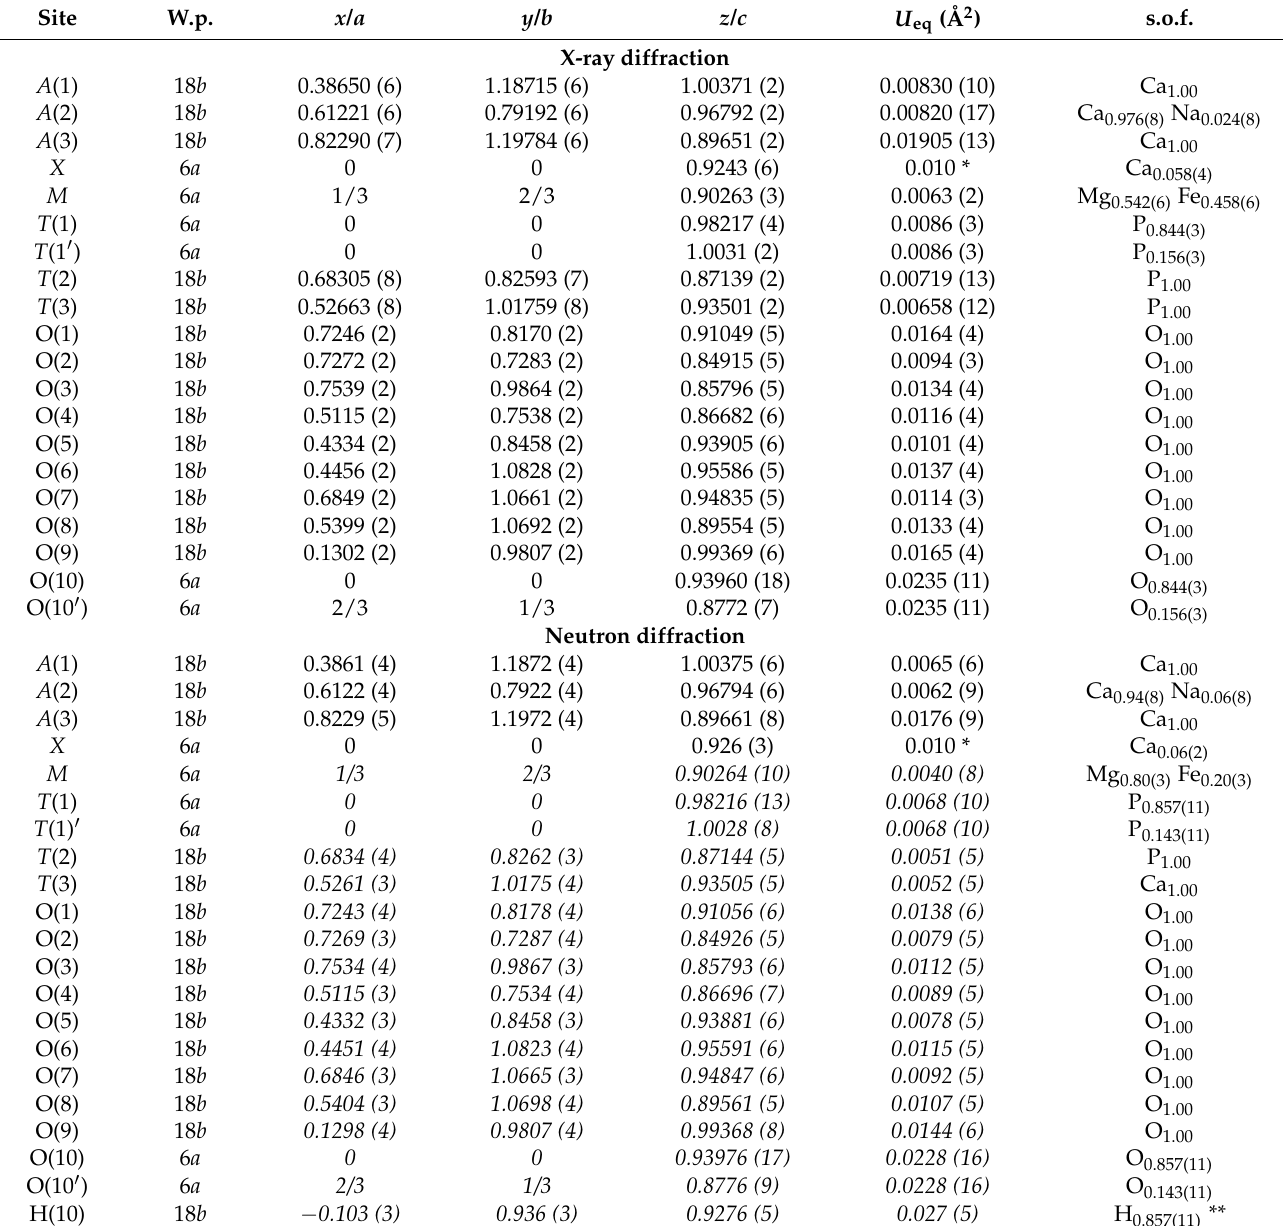
Table 3. Crystallographic site, Wyckoff position (W.p), fractional atom coordinates, equivalent atomic isotropic displacement parameters and site occupancy factors (s.o.f.) for the studied